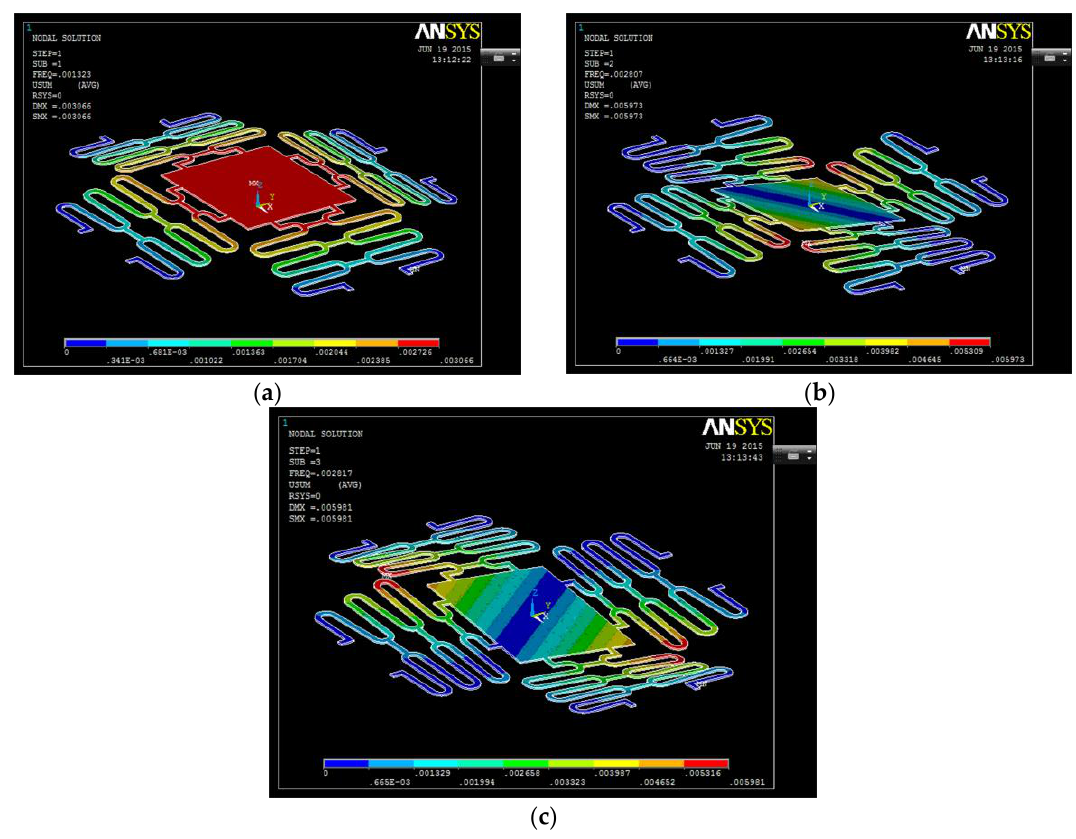
Figure 6. The three mode shapes of the microspring; ( a ) first mode; ( b ) second mode; and ( c ) third mode.